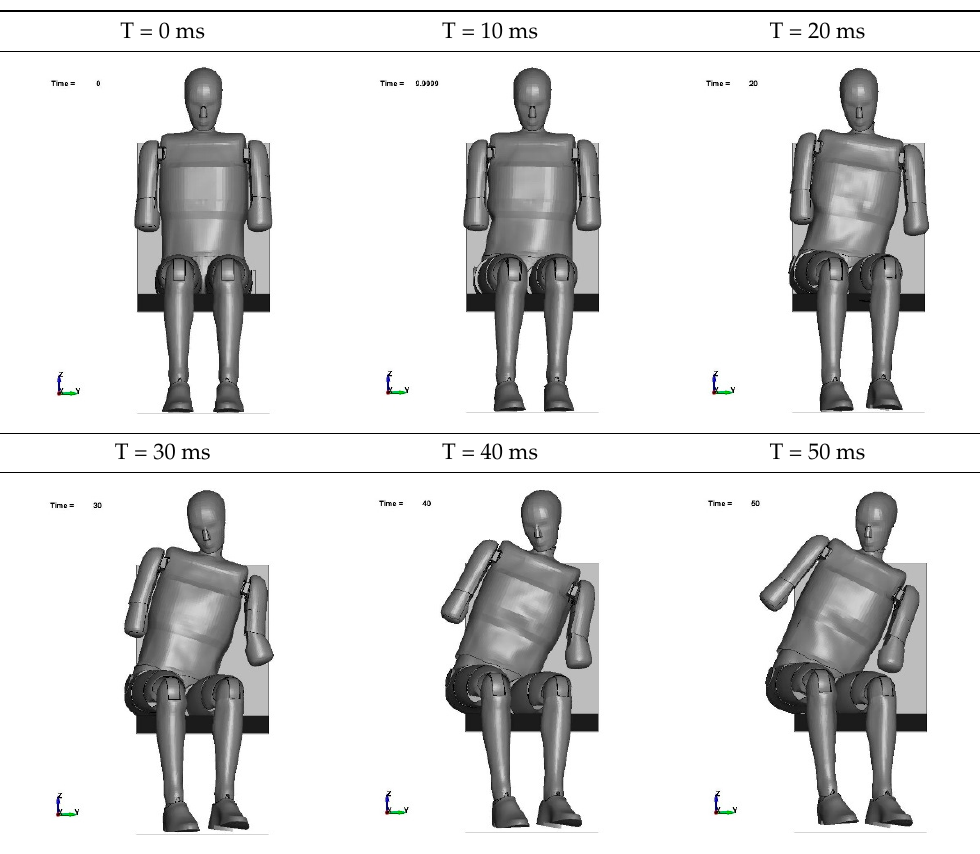
Table 3. A sequence of photos from the stages of numerical analysis of the impactor’s impact on the dummy.